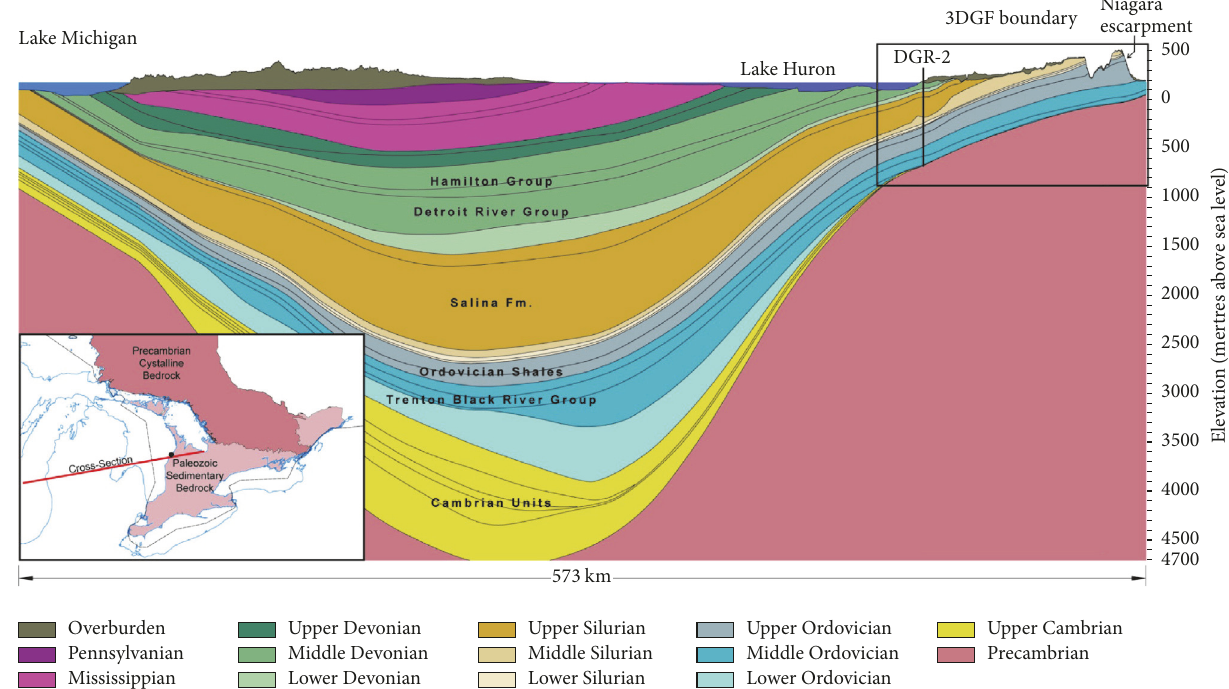
Figure 1: Cross-section of the Michigan Basin and location of the Bruce DGR. From NWMO